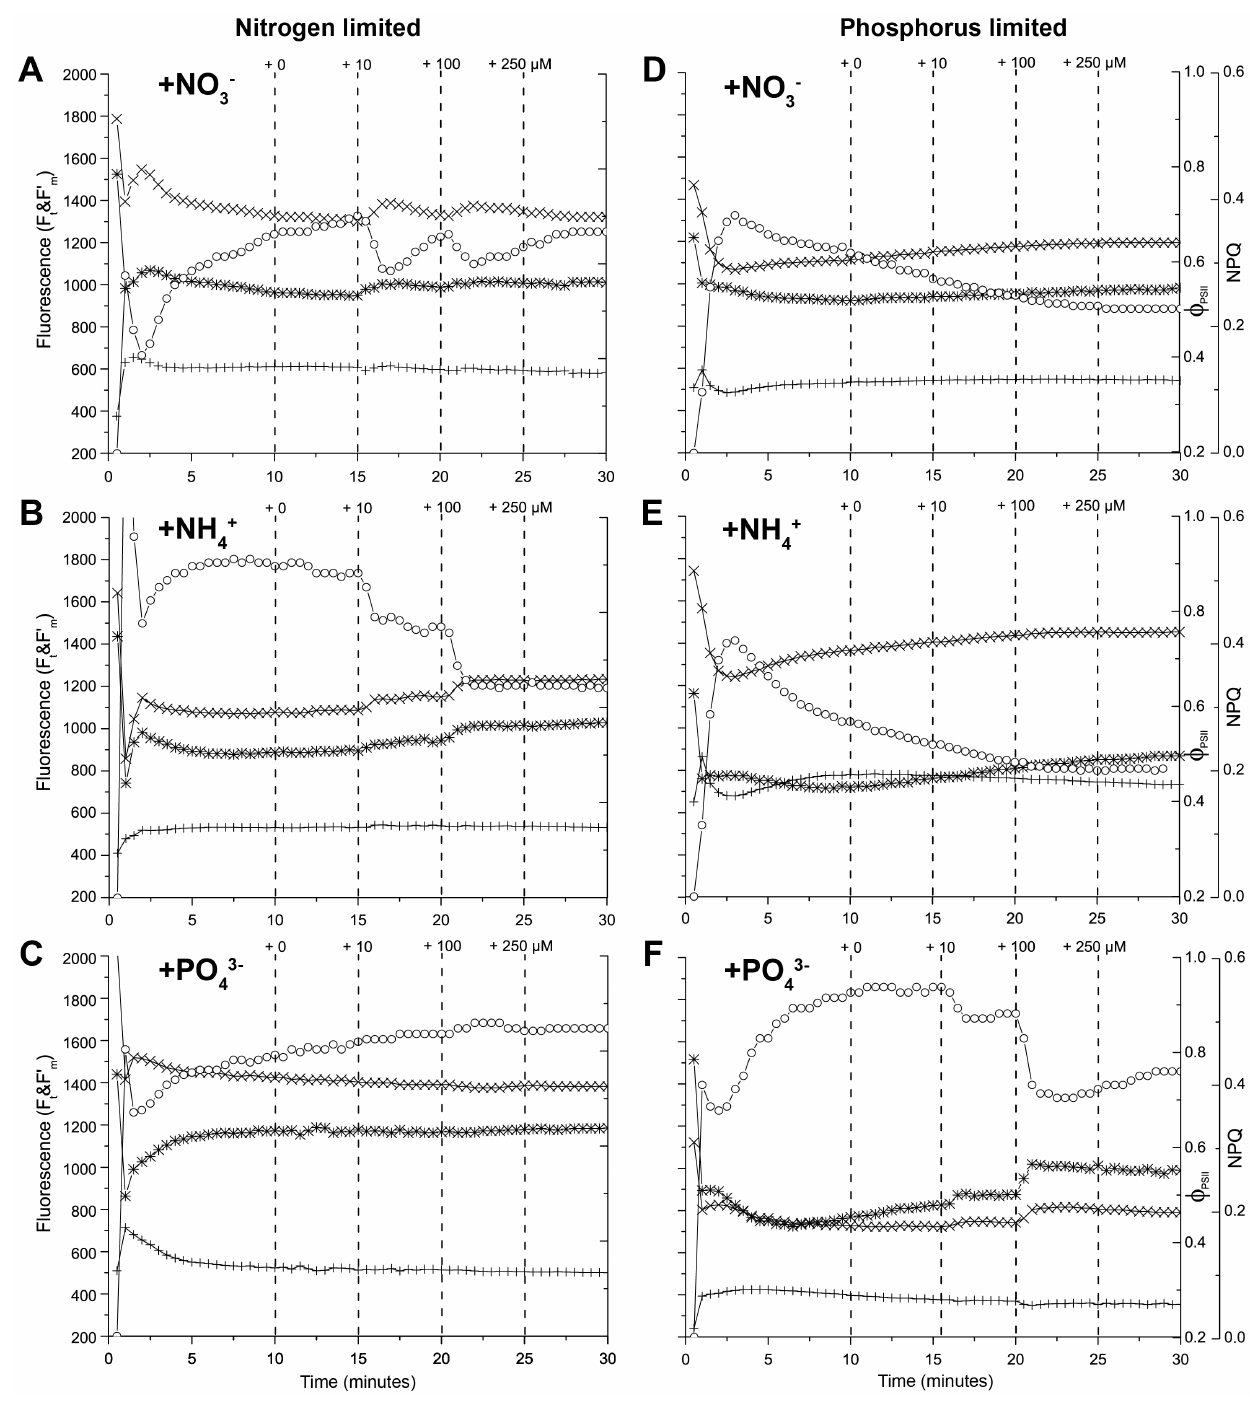
Figure 4. NIFT responses of nutrient-starved Ulvalactuca . Examples of the NIFT response of a N-starved U. lactuca leaf to (A) NO 3 2 addition, (B) NH 4 + addition, and (C) PO 43 2 addition, and a P-starved U. lactuca leaf to (D) NO 3 2 addition, (E) NH 4 + addition, and (F) PO 43 2 addition. The graphs show the time courses of steady-state fluorescence, F t ( + ); maximum fluorescence, F 9 m ( 6 ); the quantum yield of photosystem II, W PSII (); and non- photochemical quenching, NPQ ( # ). Vertical dashed lines indicate the timing of the control addition (0 m M) and three consecutive nutrient additions (10, 100 and 250 m M).